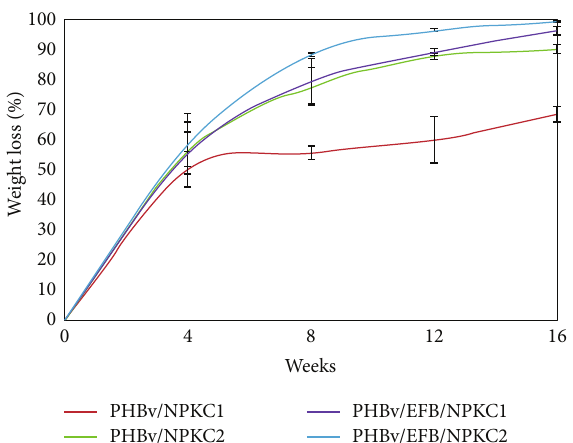
Figure 5: Mean of standard deviation and weight loss of PHBv/NPK and PHBv/EFB/NPK composites in soil burial test. Note: PHBv (poly(hydroxybutyrate-co-valerate)), NPKC1 (uncoated) and NPKC2 (coated), and EFB (empty fruit bunch), 5 replications of samples.